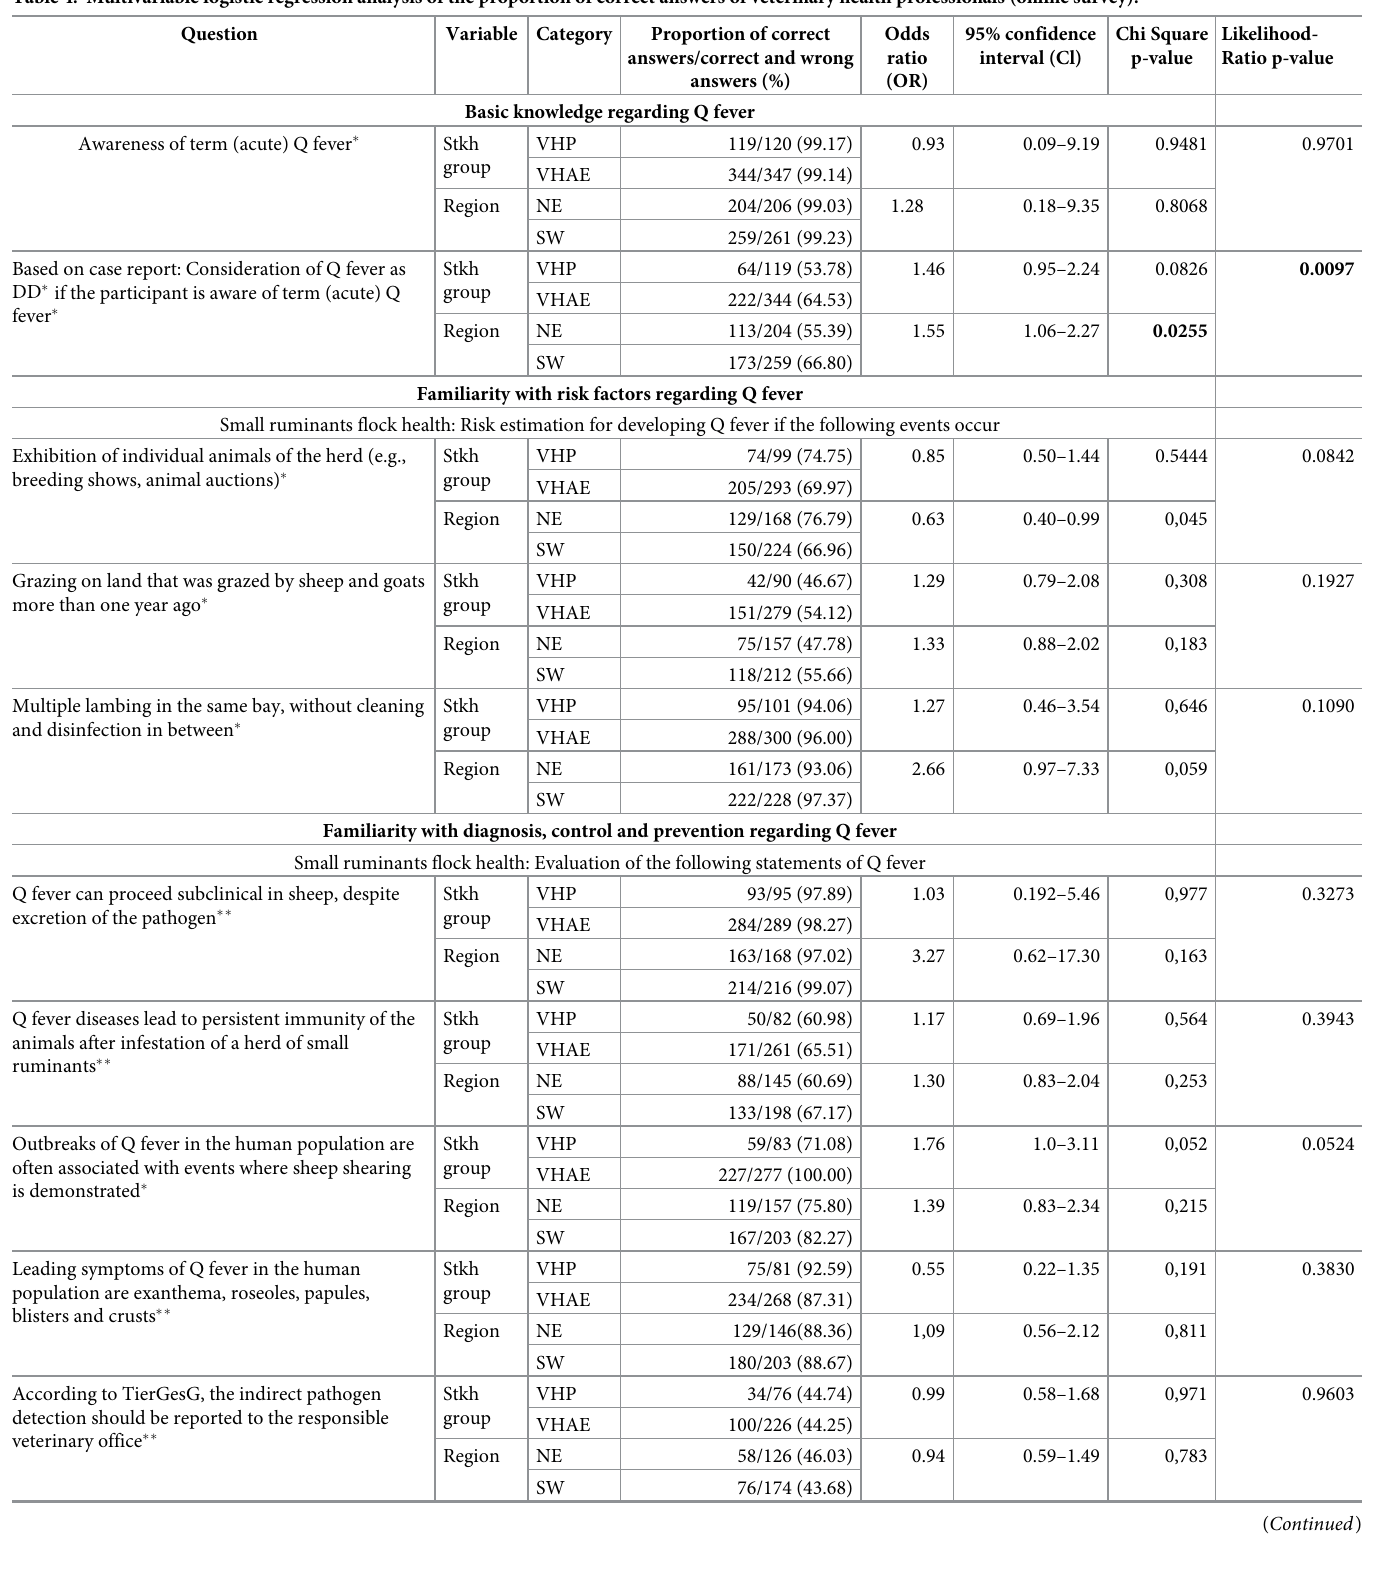
Table 4. Multivariable logistic regression analysis of the proportion of correct answers of veterinary health professionals (online